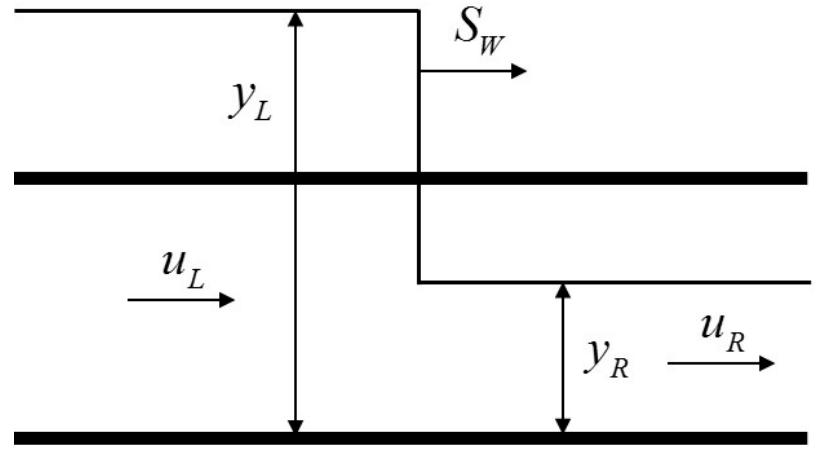
Figure 1. Description of typical filling bore problem (Test 1).